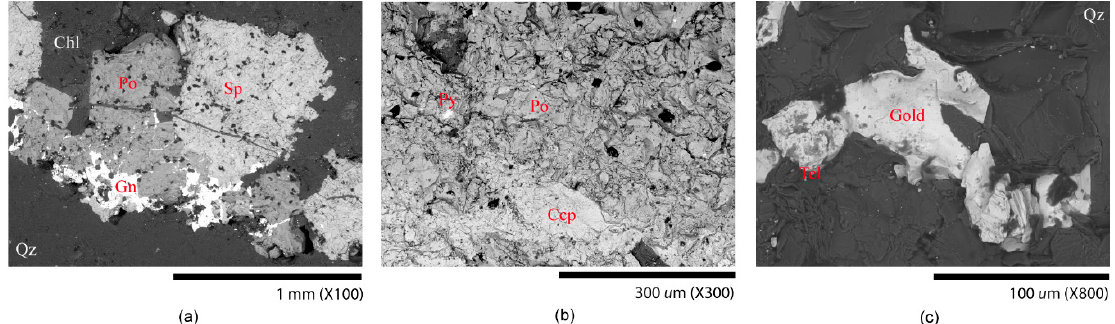
Figure 6. Backscattered electron micrographs of mineral associations. Images acquired using magnifications of 100× to 800: ( a ) MGV-1; ( b ) MS-12; and ( c ) MB-21 (assemblages of gold and telluride (hessite) in quartz vein).